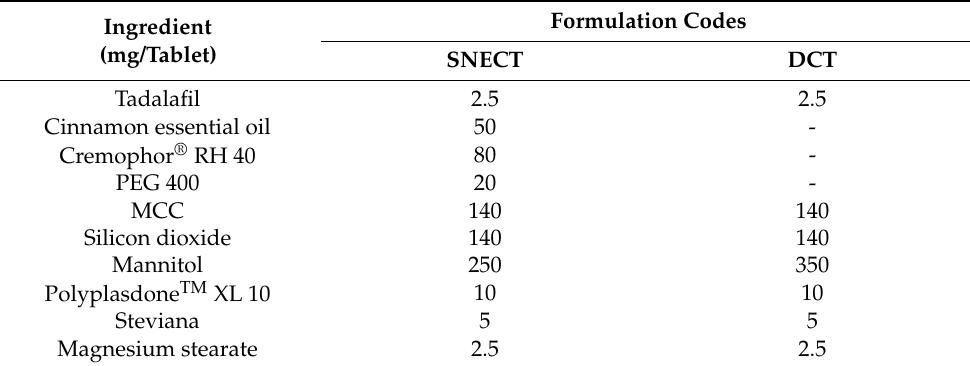
Table 2. Ingredients of tadalafil tablet